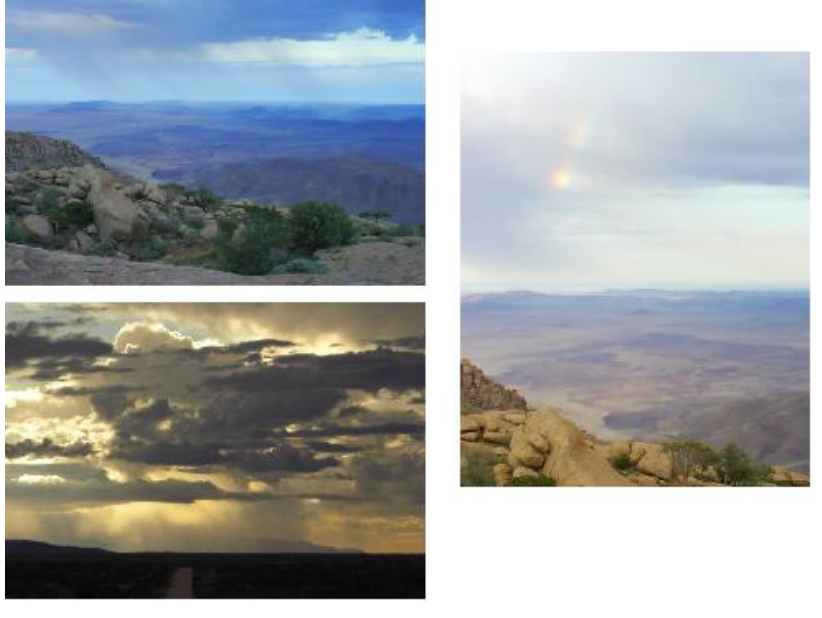
Figure 5. Scenes in west Namibia of the rain “standing in the sky”. Source: Sian Sullivan, personal